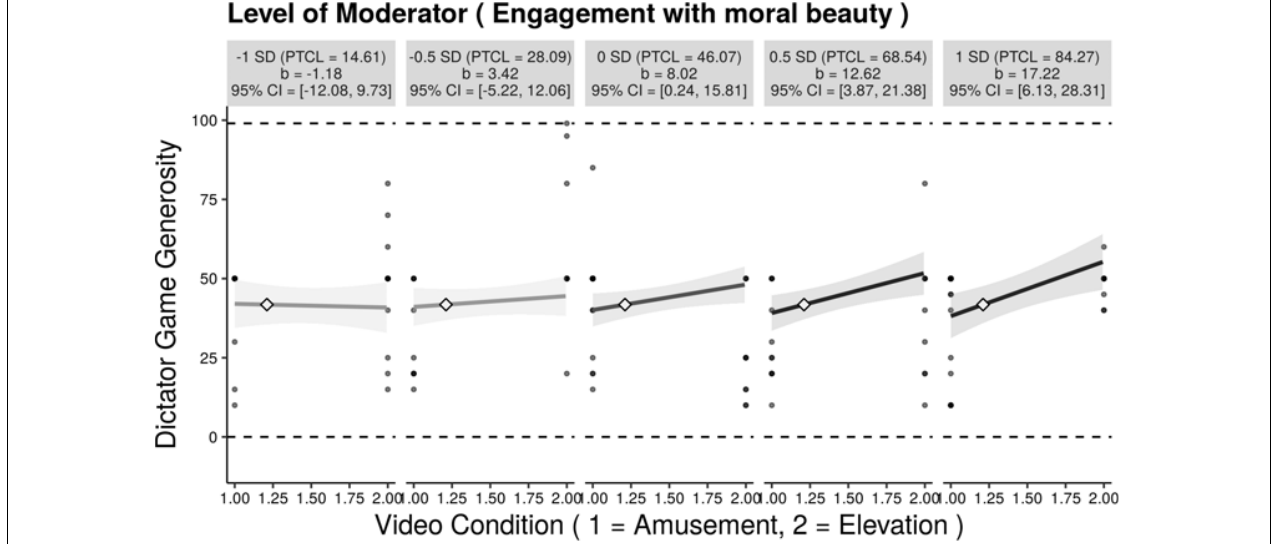
FIGURE 3 | Small-multiples depictions of the interaction effect of video condition and Engagement with moral beauty (the moderator) on dictator game generosity (active cooperation). The small multiples illustrate the interaction across the range from 1 SD below to 1 SD above the mean of Engagement with moral beauty. Each graphic shows the computed 95% confidence region (shaded area), the observed data (gray circles), the maximum and minimum values of the outcome (dashed horizontal lines), and the crossover point (diamond). CI = confidence interval; PTCL = percentile. The results depicted are those using the trimmed sample, N = 85.